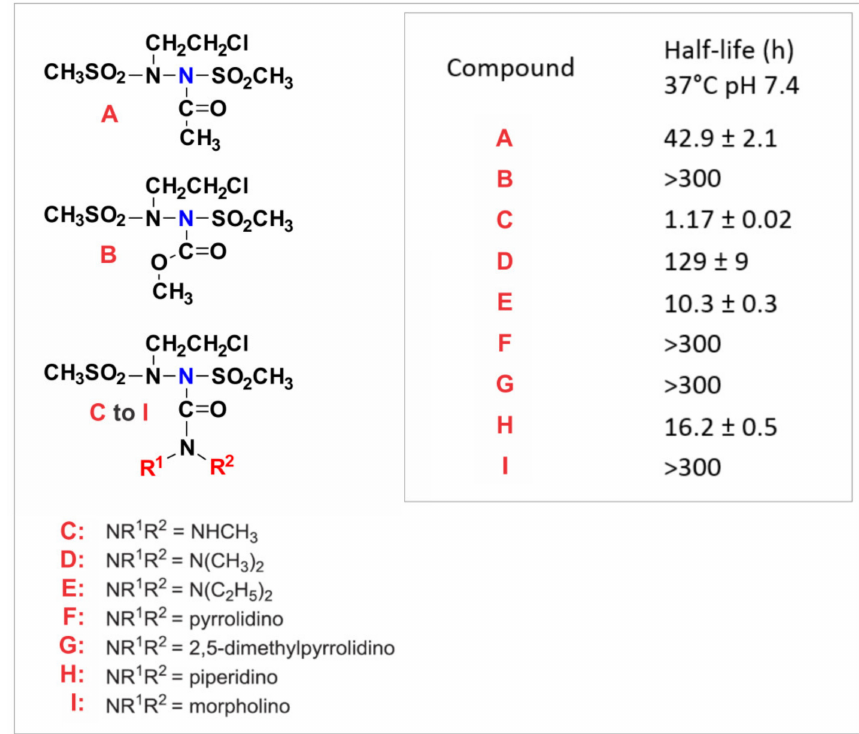
Figure 4. The half-life of simple 90CE prodrugs with different N-2 substituents. The half- life/spontaneous hydrolysis rate of various low molecular weight 90CE prodrugs was determined (37 ◦ C, pH of 7.4). It was noted that the stability of some of these linkages would allow sufficient time for macromolecular prodrug analogs to be accumulated by tumor tissues before any significant systemic activation